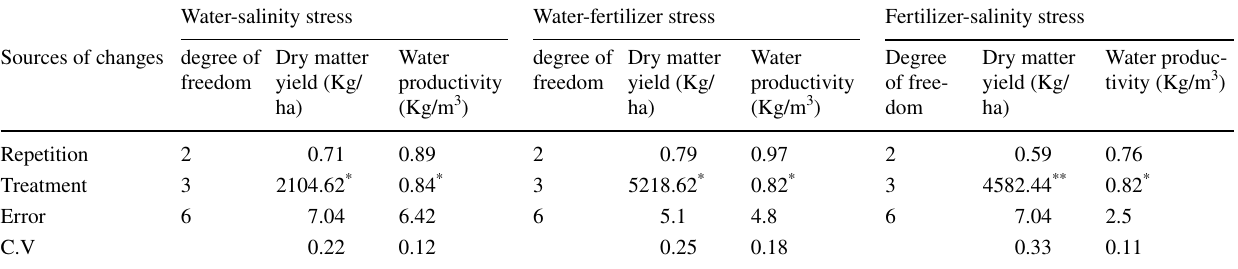
Table 7 Analysis of the variance in yield and water productivity of basil water consumption under pairs of water, salinity, and fertilizer stresses Sources of changes degree of Dry matter freedom yield (Kg/